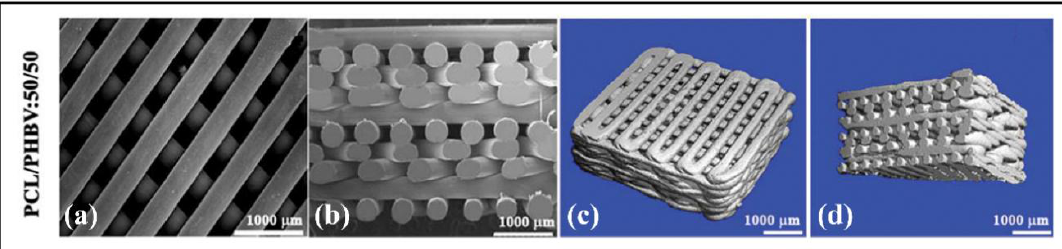
Figure 7. Microstructures of PCL/PHBV:50/50. Scaffolds examined by SEM microscopy ( a , b ) and by microcomputerised tomography ( µ -CT) ( c , d ). Reproduced with permission from Ref. [187].